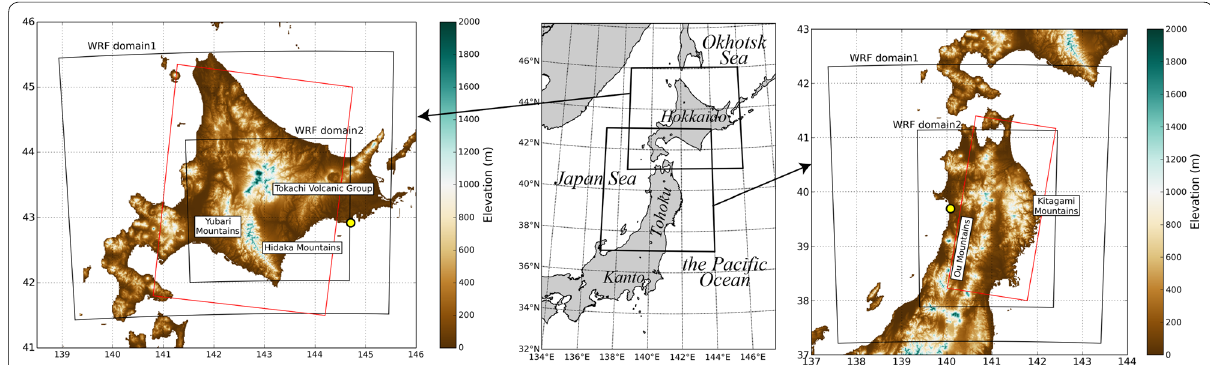
Fig. 1 Regions of interest Thin black boxes in left and right figures indicate domains of WRF simulations and red boxes indicate SAR observation